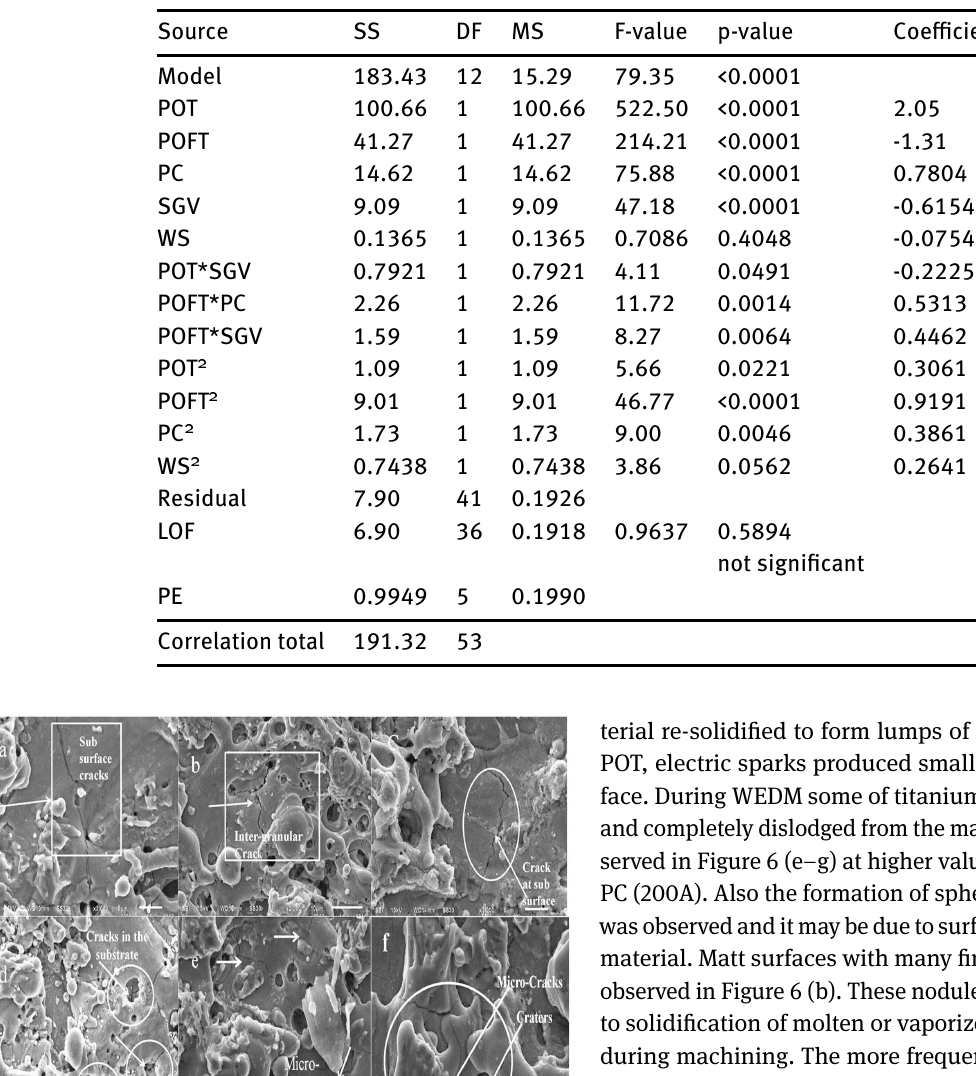
Table 3: ANOVA for MRR (Reduced quadratic after backward elimination).